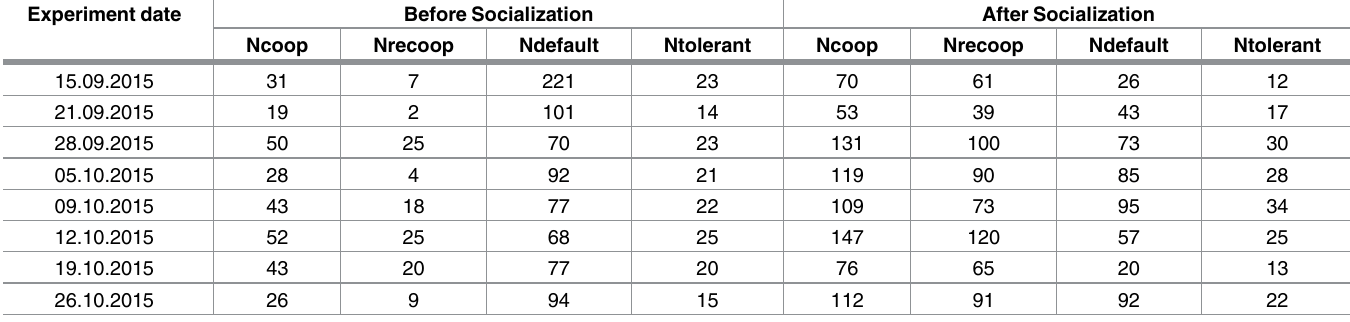
Table 5. Number of cooperative and non-cooperative moves, reciprocal cooperation and tolerance to defection in PD before and after Socialization. Experiment date